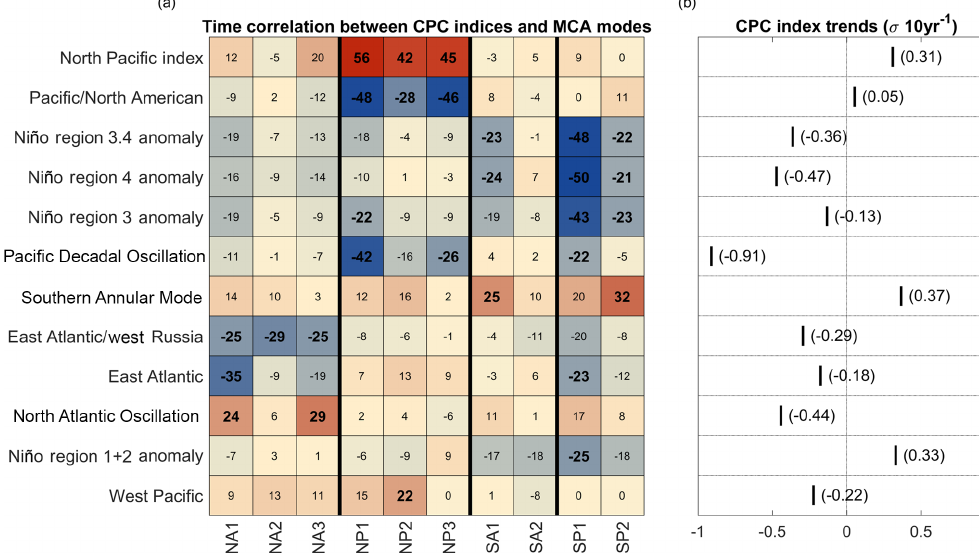
Figure 4. Correlation matrix between time series computed for each MCA mode shown in Fig. 3 and each of the CPC climate indices (a) . The numerical values in (a) are correlation coefficients with the decimal point omitted, bold values indicate significance ( p < 0 . 01), coloring also denotes the sign and magnitude of the correlation. Only CPC indices with significant correlations with at least one MCA mode are included. The climate indices are sorted such that those that describe the most variance averaged across all MCA modes appear near the top. Panel (b) shows normalized trends in the CPC indices between 2000 and 2013, along with their magnitude expressed in standard deviations, showing for example, that the Pacific Decadal Oscillation (PDO) index was trending lower between 2000 and 2013, while the North Pacific index (NPI) and Antarctic Oscillation/Southern Annular Mode (AAO/SAM) index